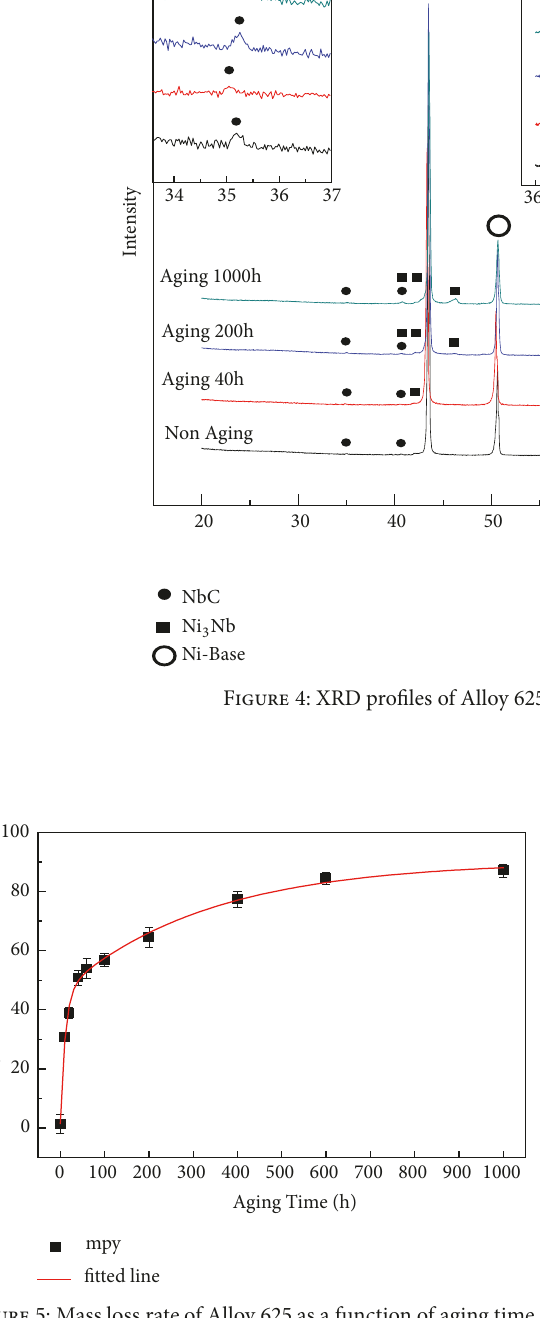
suggesting a preferential dissolution of Ni 3 Nb. With the increase of aging time, the surface grains have completely dropped, as shown in Figure 6(d), and correspondingly the corrosion rate rapidly increases. Note that the Alloy 625 specimen exhibits two types of precipitation phase: one is the detached needle like 𝛾 󸀠󸀠 -Ni 3 Nb from the surface, and the other is the detached lamellar like 𝛿 -Ni 3 Nb, as indicated by the red and yellow arrows in Figure 6(f),